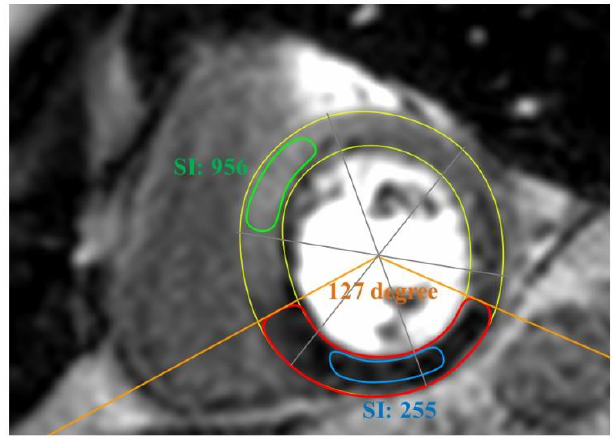
Figure 1. Exemplificative analysis of ischemia in CMR. Myocardial area: manual tracking of endocardial and epicardial border (yellow). Segmentation of the myocardium according to the standardized AHA 16 segment model (grey). Ischemic area (red) with signal intensity (SI ischemia) measured in the center (blue). Signal intensity (SI) of remote myocardium (green). The circumferential extent of ischemia (orange) is measured as the angle of ischemia with vertex at the center of the AHA 16 segment model. Ischemic signal intensity (SI) ratio: SI ischemia/SI remote × 100. Percentage of ischemic burden = ischemic area/total myocardial area × 100.